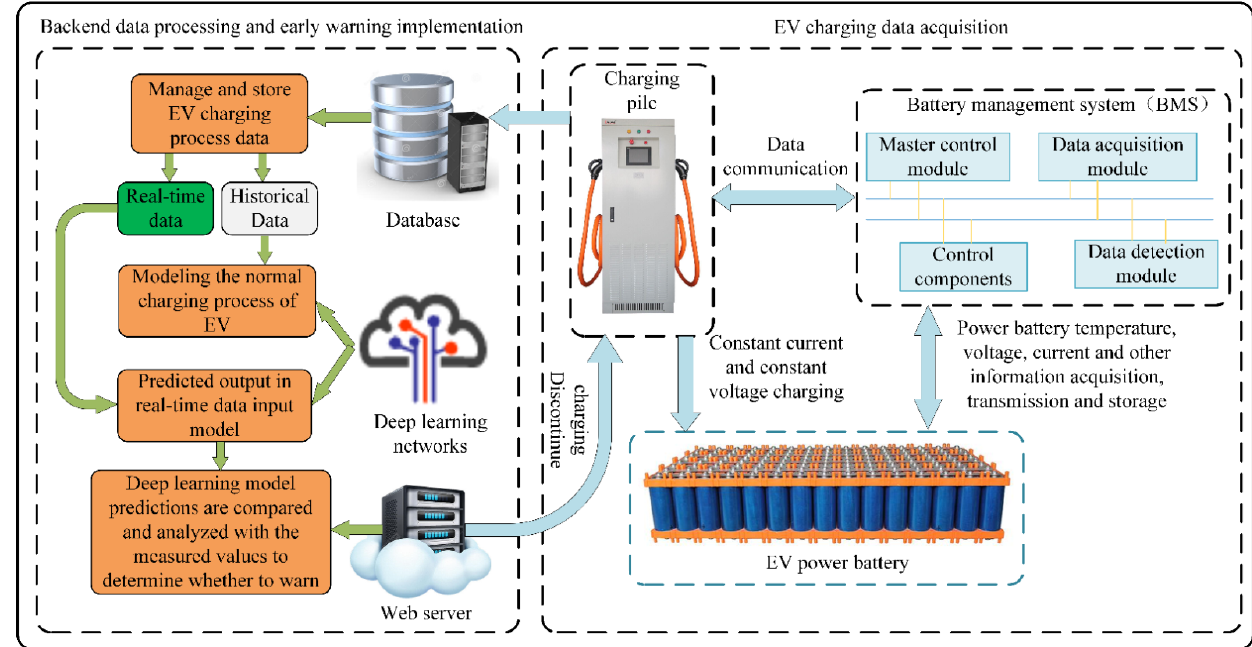
Figure 1. Electric vehicle (EV) charging process and its warning block diagram.